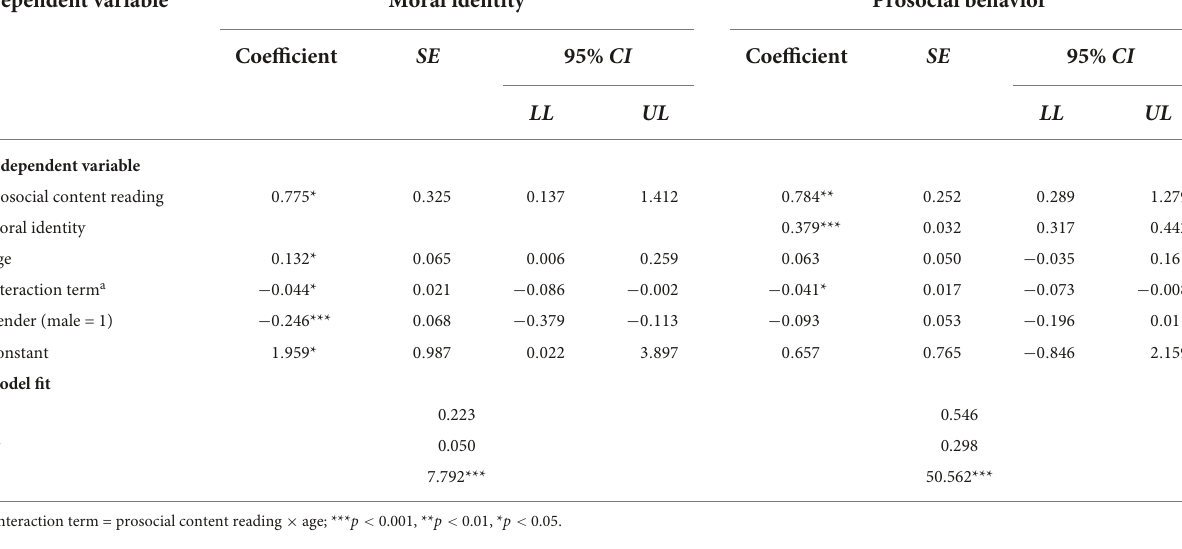
TABLE 3 Regression analysis results.